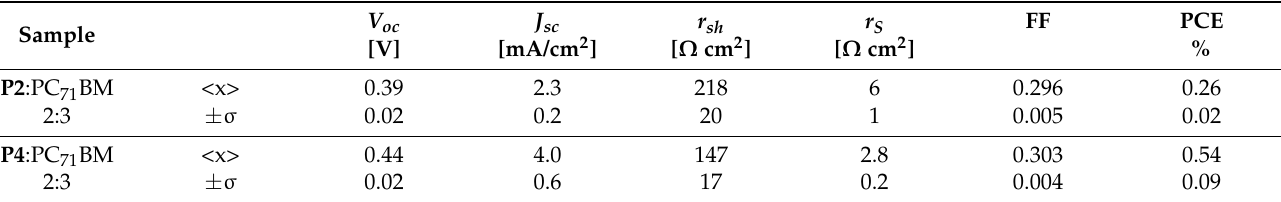
Figure 6. Current—voltage characteristics of solar cells with P2 :PC 71 BM (red) and P4 :PC 71 BM (blue) heterojunctions. Table 3. Photoelectric parameters of the investigated solar cells.